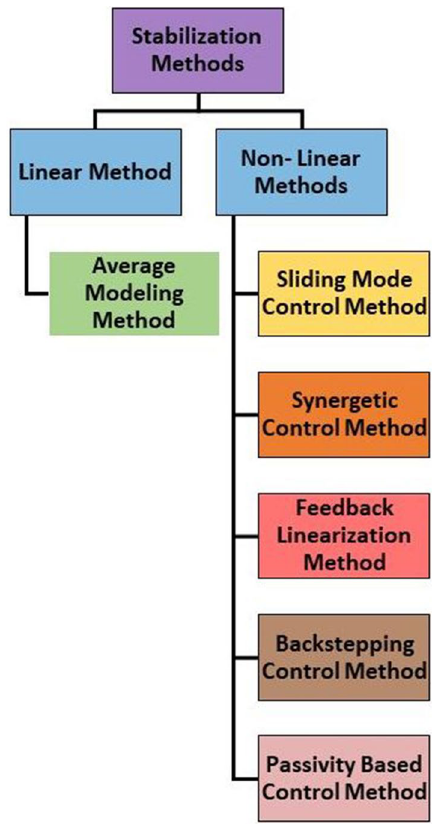
Fig. 6 Linear and non-linear stabilization